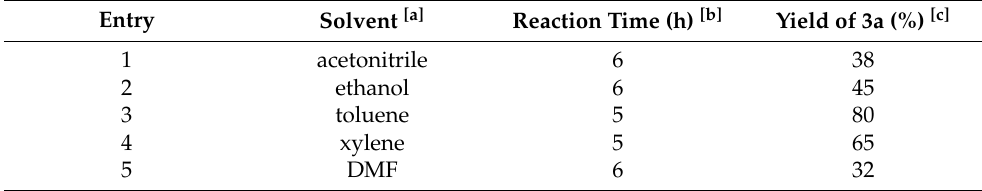
Table 1. Effect of different solvents on synthesizing the fused cholestane pyrrole 3a at reflux.